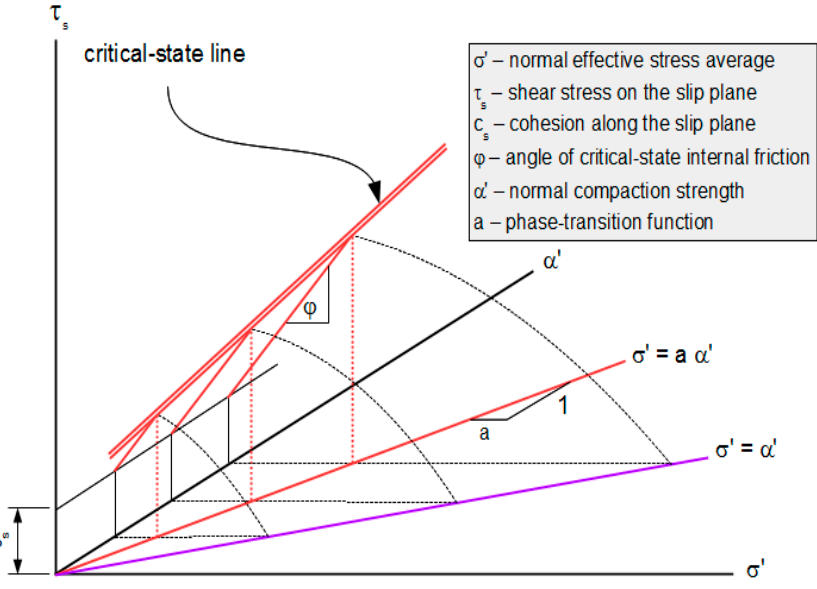
Figure 5. Critical-state line for shearing mode ω = 1/2.